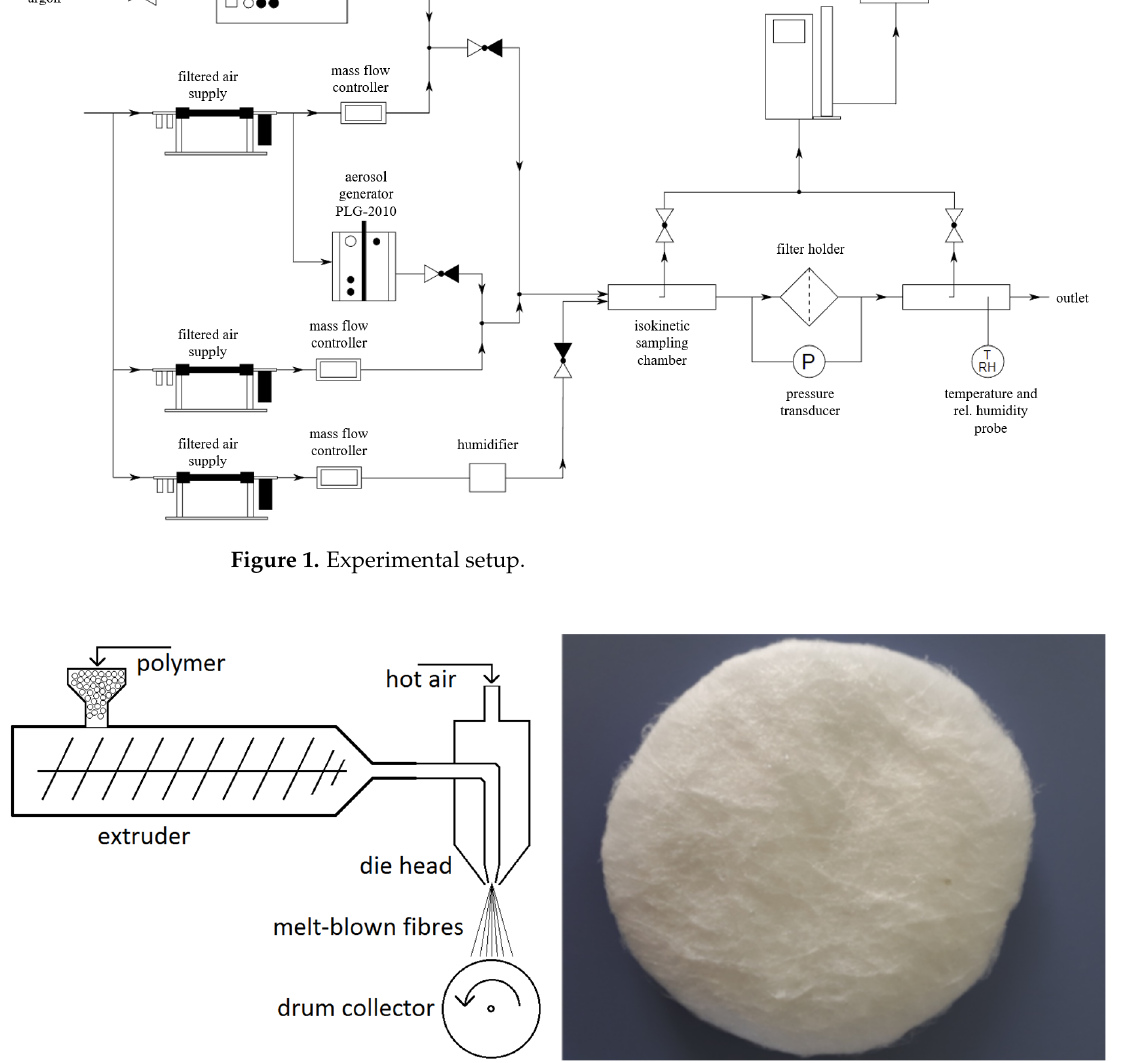
Figure 1. Experimental setup.